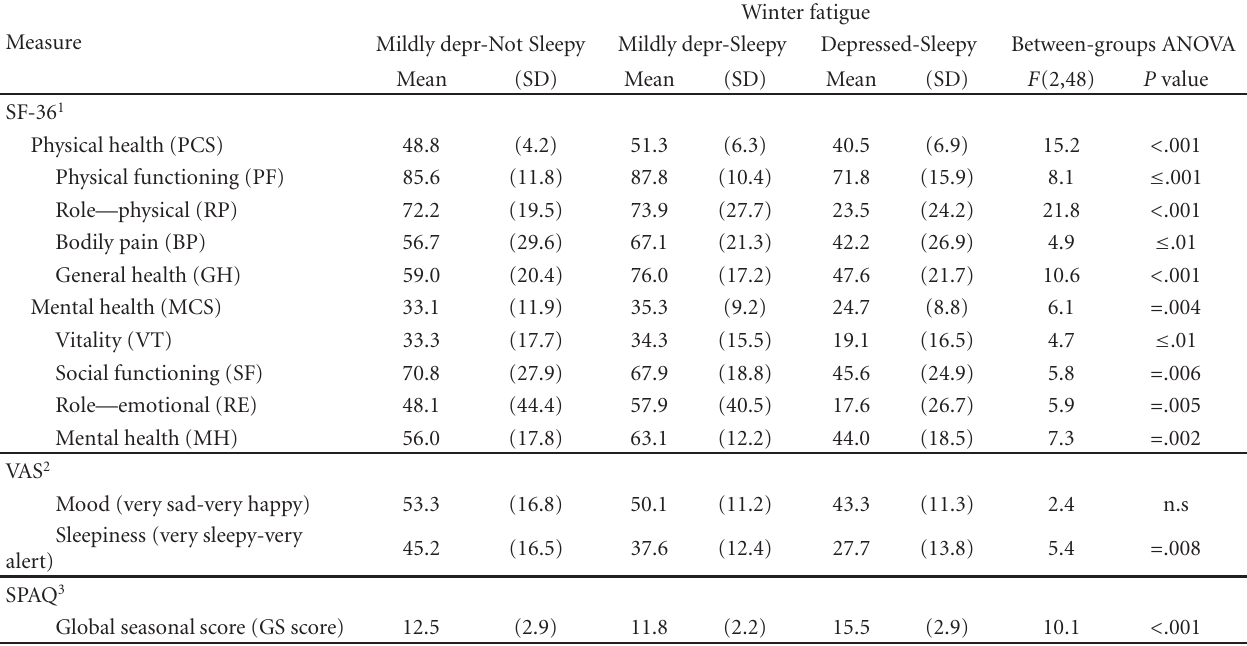
Table 3: Results for the three clusters on independent measures at baseline, that is, other measures than those used in the formation of clusters at baseline ( N =